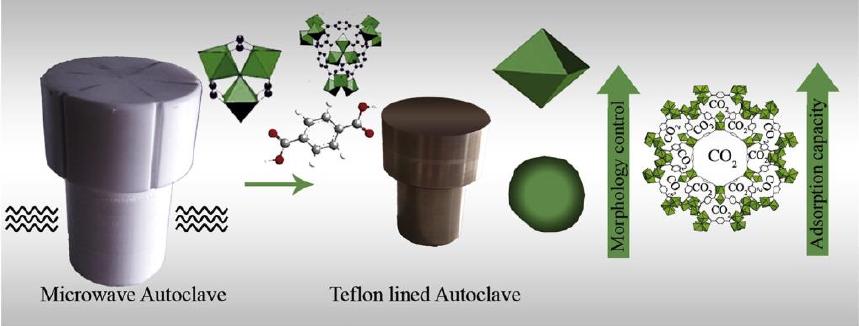
Figure 5. Two-step synthesis of MIL-101(Cr) by microwave-assisted and electric heating methods [39]. Reprinted with permission from ref. [39]. Copyright © 2022, American Chemical Society.